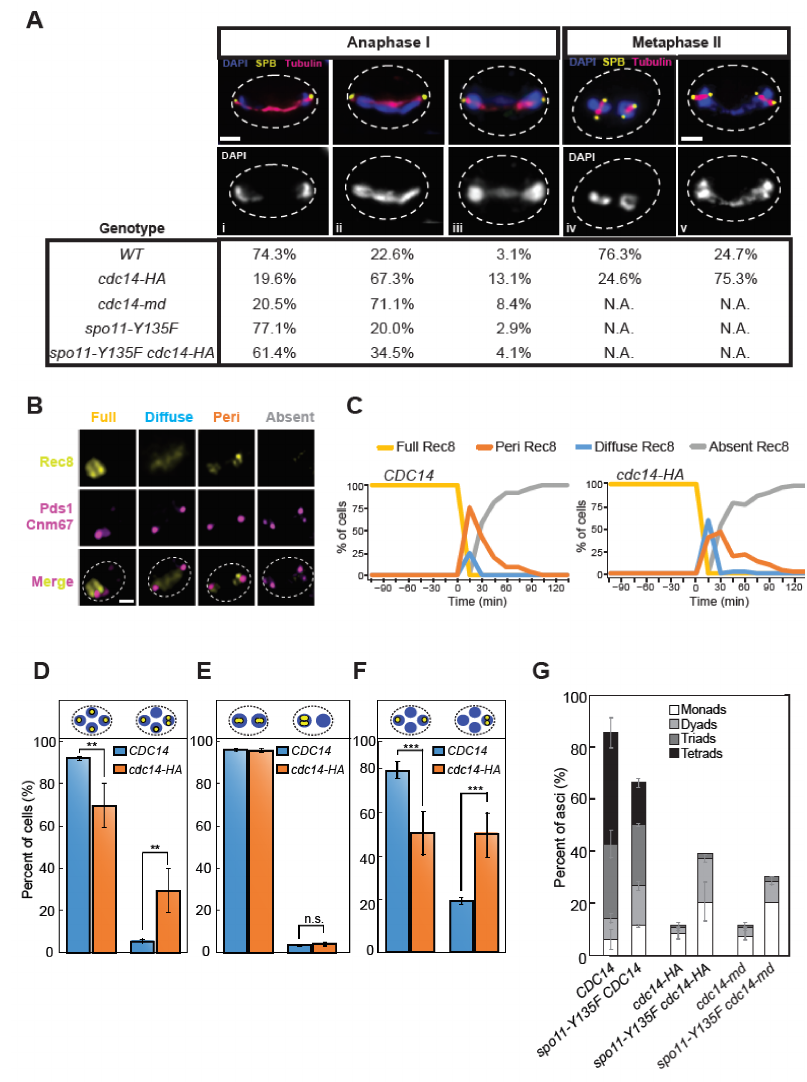
Figure 3. Mis-segregation of sister chromatids at MII in meiosis-deficient cdc14 mutant cells. ( A ( i – iii )) Frequency of cells presenting connected DAPI masses at anaphase I in wild type (JCY902), cdc14-HA (JCY904), cdc14-md (PRY132), spo11-Y135F (PRY53) and spo11-Y135F cdc14-HA (PRY55). ( A ( iv , v )) Frequency of cells presenting connected nuclei at metaphase II. Meiotic-deficient cdc14-HA mutants (GGY54) present higher frequencies of unresolved nuclear divisions at late anaphase I and at metaphase II than wild type (GGY53). ( B ) Representative images of distinct morphological patterns for Rec8-GFP in meiosis. Full: bright nuclear localization. Diffuse: faint staining within the stretched nucleus. Peri: Rec8-GFP only visible at peri-centromeric locations. Absent: no Rec8-GFP signal. Pds1-tdTomato and CNM67- tdTomato were used to follow Pds1 accumulation/degradation and SPB number/location. ( C ) Temporal distribution of the distinct morphological categories of Rec8-GFP shown in ( B ) for CDC14 (JCY2406; n = 57 cells) and cdc14-HA (JCY2404; n = 52 cells). ( D ) Unequal distribution of homozygous chromosome II-linked GFP markers at lys2 locus in cdc14-HA mutant cells (JCY2330) denotes increased chromosome missegregation in comparison with wild-type cells (JCY2331). ( E ) Similar distribution of homozygous CENIV -linked GFP markers at trp1 locus in meiosis-deficient cdc14-HA mutant cells (JCY2286) in comparison with wild-type cells (JCY2284) denotes correct homolog disjunction in anaphase I. ( F ) Unequal distribution of heterozygous CENIV-GFP marker in meiosis-deficient cdc14-HA tetranucleated mutant cells (JCY2327) denotes increased sister chromatid missegregation in comparison with wild-type cells (JCY2326). Statistical significance of differences was calculated by two-tailed t -test, assuming unequal variances (* p < 0.05; ** p < 0.01; *** p < 0.001; **** p < 0.0001; n.s.: not significant). ( G ) Sporulation defects in cdc14-HA (JCY844) or cdc14-md (JCY2376) can be partly alleviated by eliminating recombination (JCY2270/JCY2280/PRY151). CDC14 (JCY840). Error bars represent SEM over the calculated mean value from three independent experiments. A minimum of 300 cells per strain were